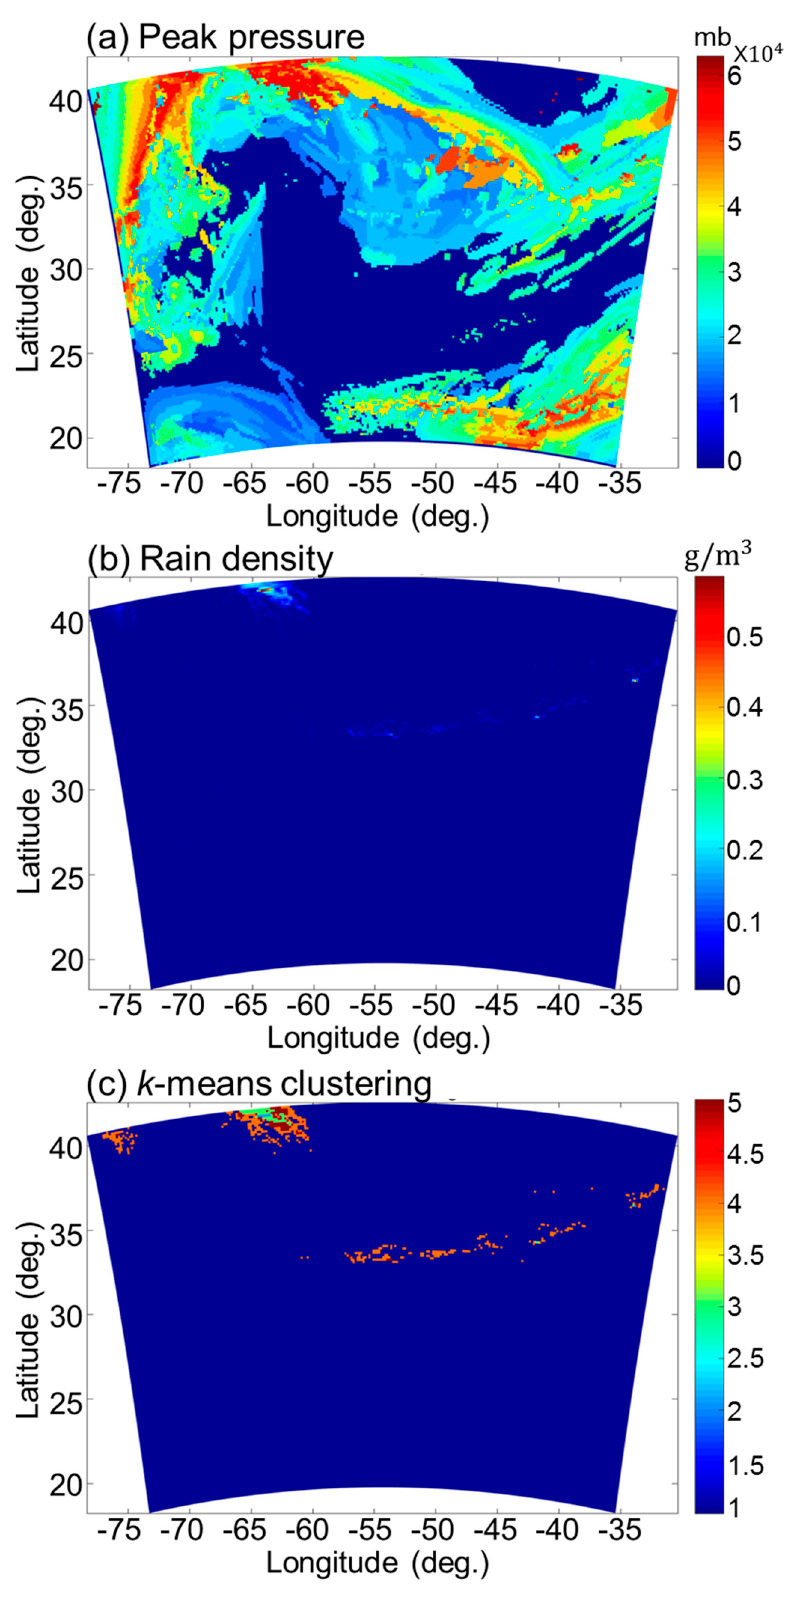
Figure 4. Maps of: ( a ) pressure; ( b ) rain density distribution; and ( c ) k -means clustering results based on the three elements illustrated in Figure 3.